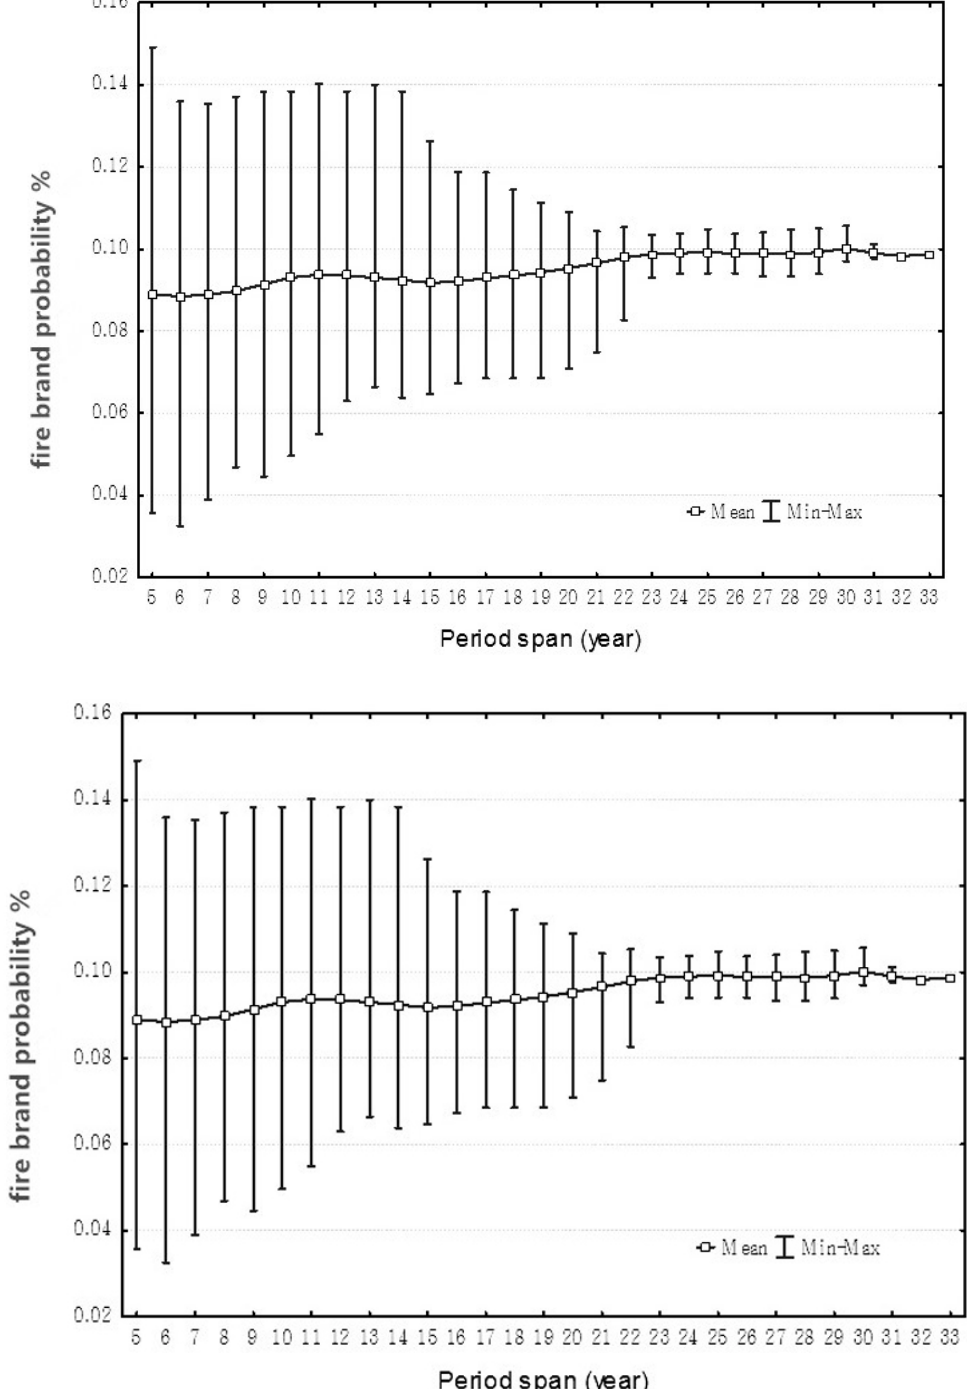
Figure 9. Fixed daily firebrand probability of periods with different time spans.